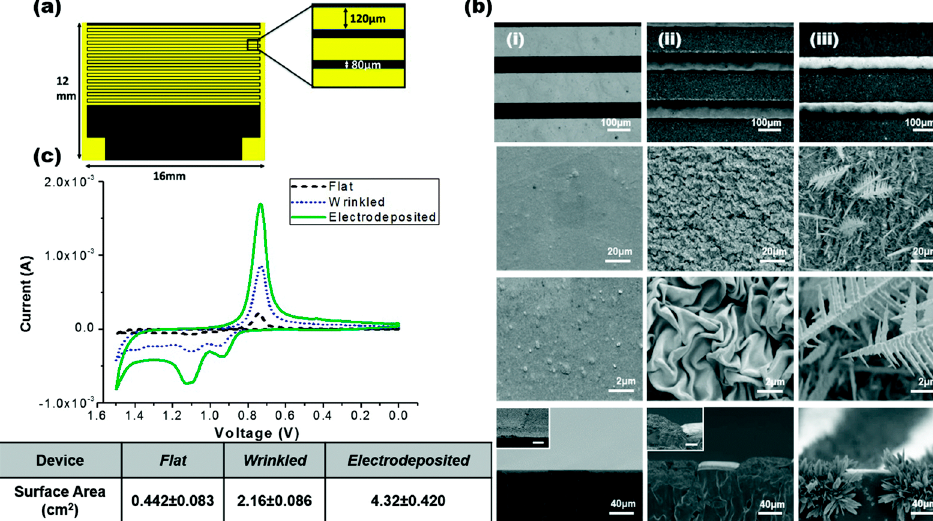
Figure 16. Bacterial lysis device: ( a ) schematic of the lysis device; ( b ) scanning electron micrographs of: ( i ) planar; ( ii ) wrinkled; and ( iii ) electrodeposited electrodes; ( c ) cyclic voltammetry scan of the electrodes. Reproduced with permission from [92].